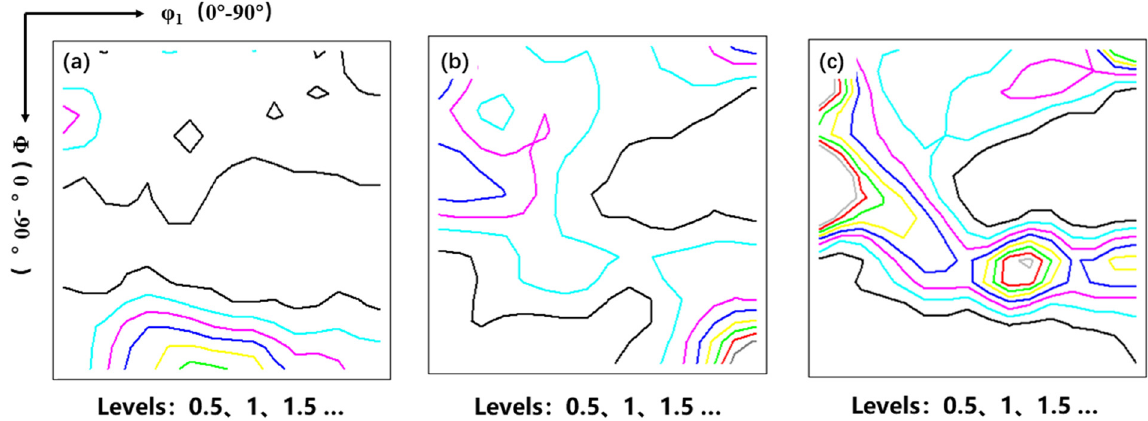
Figure 12: ODF diagram of φ 2 = 45° at di ff erent thicknesses of Y - free hot - rolled sheet: ( a ) S = 0; ( b ) S = 1/4; and ( c ) S =